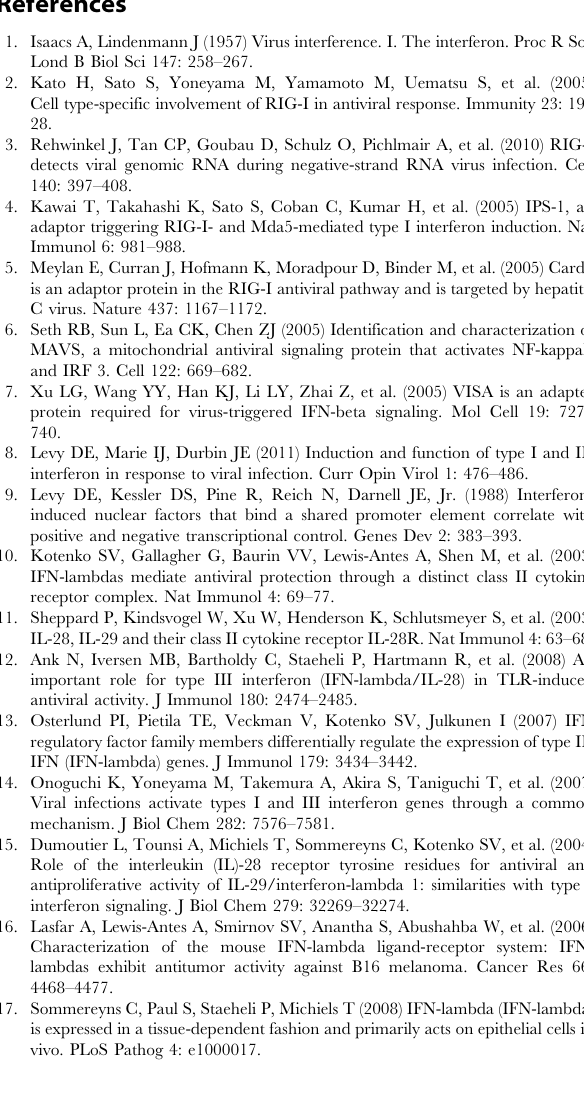
Figure S6 Confirmation of successful bone marrow grafting in chimera experiments. Seven weeks after BM graft, mice were bled from the tail vein. Blood was collected in heparin and stained with the following antibodies: CD19 (6D5), Gr-1 (1A8), CD4 (RM4-5), CD8 (53-6.7) and IFNAR1 (MAR1-5A3). Samples were read by FACSCanto (BD Bioscience) and analyzed by FlowJo 9.6.2. Cells from wild-type C57BL/6 (solid grey), IFNAR1 2 / 2 (black line) and chimeric mice (coloured lines) are